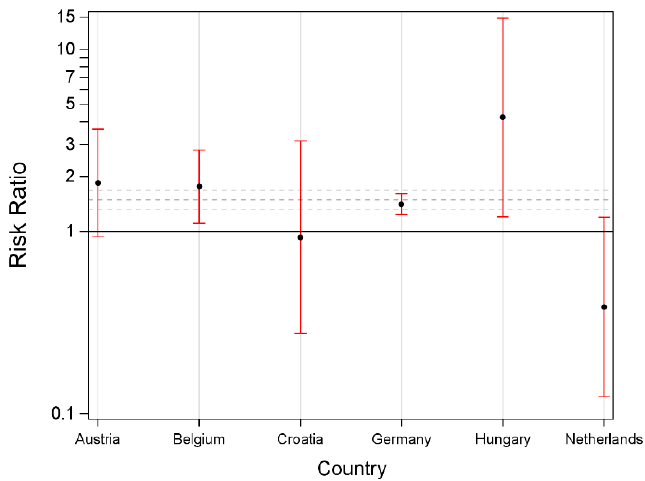
Figure 2. Risk ratio for being removed from the waiting list depending on sex by country.